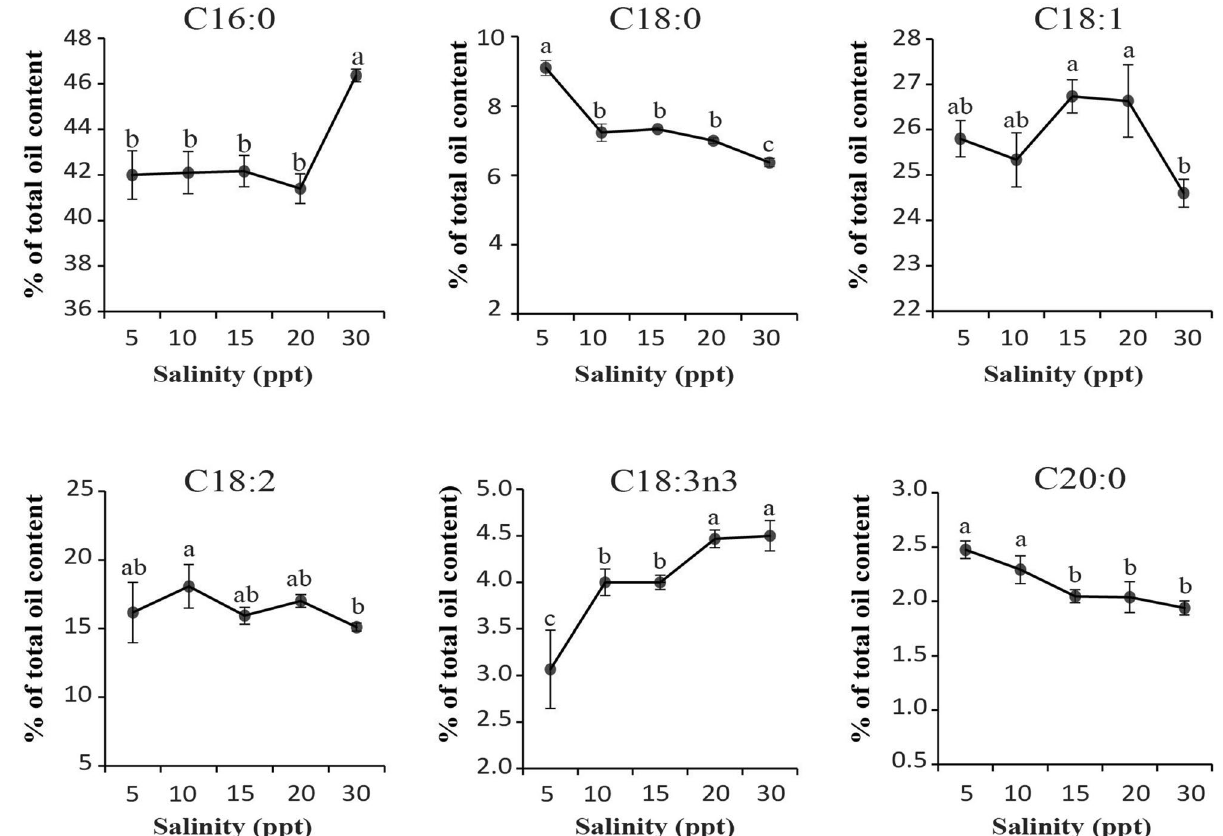
Figure 3. Distribution of changes in composition of the major fatty acids under different salinity treatments in C. vulgaris UMT-M1. All values represent means ± SD of three biological replicates. Different series of letters are significantly different according to Fisher’s LSD test (SPSS software) ( p <